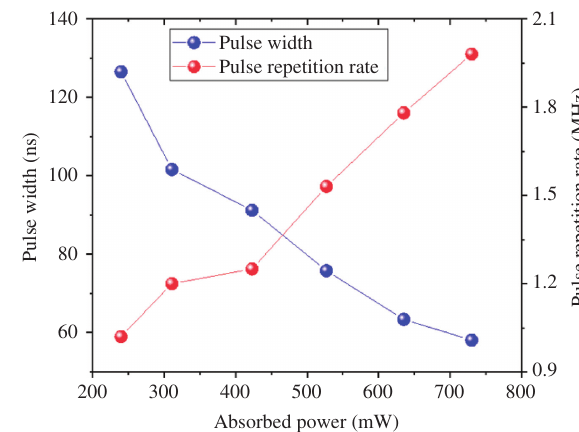
Figure 7: The single pulse profile showing a pulse time duration of about 58.1 ns; inset: pulse trains at maximum output power with repetition rate of 1.98 MHz.